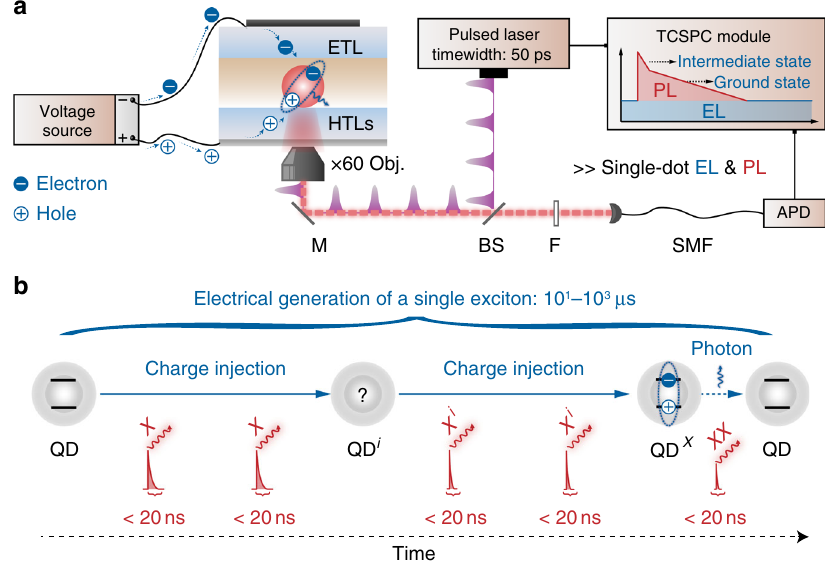
Fig. 1 Electrically pumped single-nanocrystal spectroscopy. a Schematic diagram of the experimental setup. Electrical excitation (voltage source) and optical excitation (450 nm pulsed laser) are simultaneously applied on the single QD. Intensities and time-correlated single-photon-counting data are recorded simultaneously, enabling probe of states relevant to the single-dot EL. Optical excitation is kept in the single-exciton regime (average excitation per pulse <0.1) so that it does not alter the charging status of the single QD. b Temporal evolution of a single QD under electrical excitation. The pulsed laser serves as a fast and non-invasive probe. The average time of an EL cycle is substantially longer than the characteristic lifetimes of optically excited states. QD i represents the possible intermediate states for single-dot EL processes (blue arrows). The corresponding optically excited states are denoted as X i (in red).